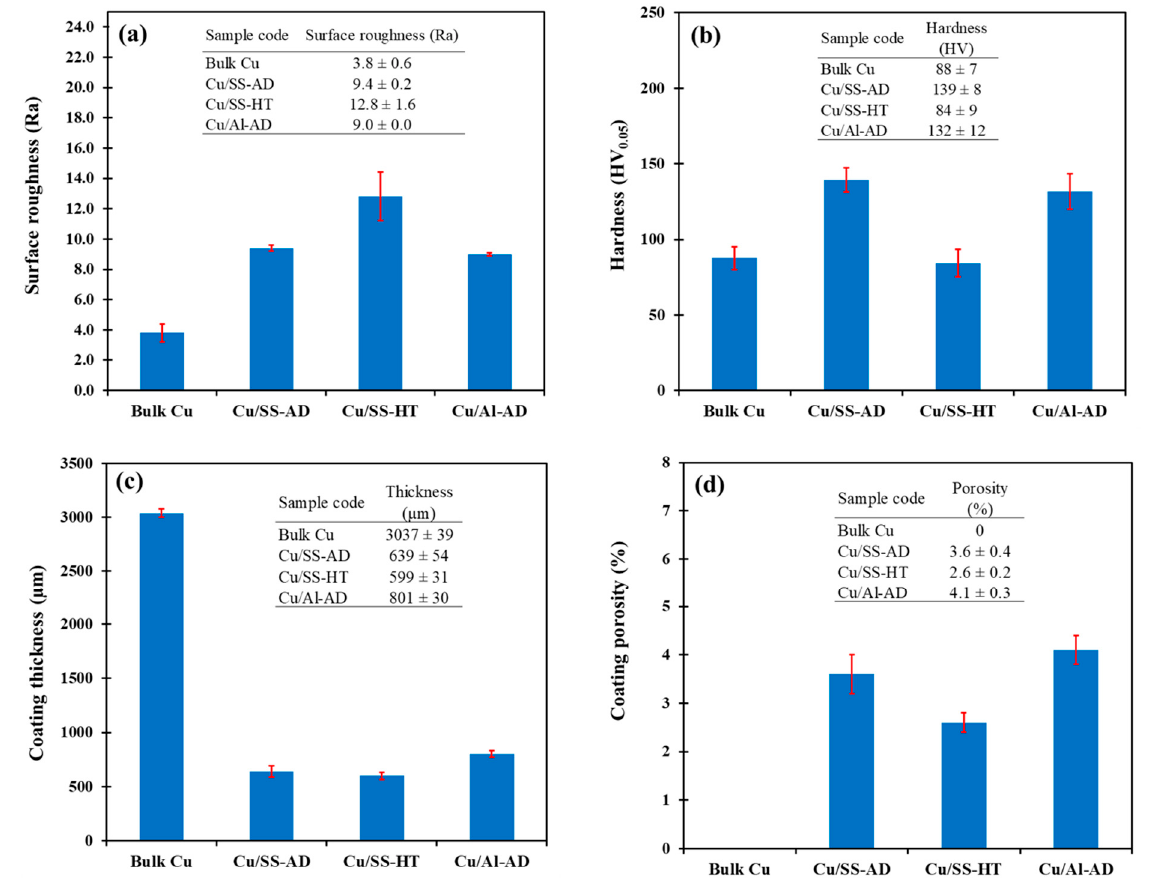
Figure 9. Properties of bulk Cu and Cu-coated samples: ( a ) surface roughness (in µ m), ( b ) hardness, ( c ) coating thickness, and ( d ) coating porosity.